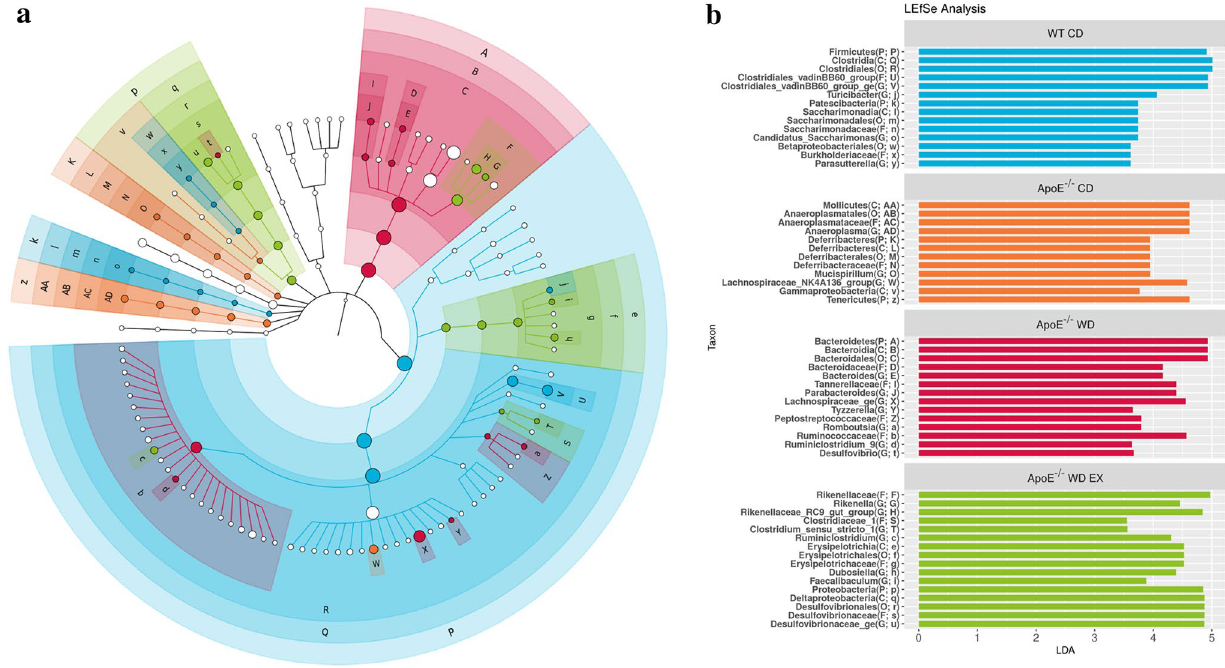
Figure 2. Effects of endurance exercise on gut microbiota population in ApoE knockout mice. ( a ) Cladogram depicting the phylogenetic distribution of the bacterial lineages associated with statistical differences in LEfSe analysis of the feces of different groups ( b ) LEfSe analysis of bacterial communities with LDA scores greater than 2. Differences are represented by the color of the most abundant class (light blue is WT CD; orange is ApoE CD; red is ApoE WD; green is ApoE WD EX). The abundance of each taxon is represented by each circle’s diameter in the community, with concentric circles indicating phylogenetic levels from phylum to genus.